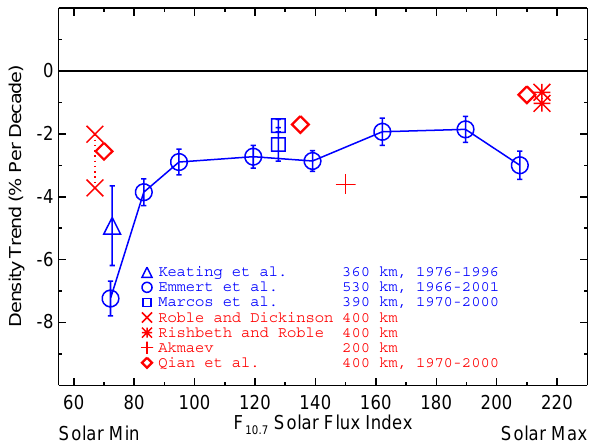
Fig. 2. Summary of density trends (with known natural variability removed) derived from the analysis of orbital tracking data, along with corresponding trends inferred from theoretical simulations of increased greenhouse concentrations. Keating et al. (2000) ana- lyzed the orbits of five objects during three solar minimum years (1976, 1986, and 1996). Emmert et al. (2004) analyzed 27 ob- jects, covering the period from 1966 to 2001, to derive long-term trends as a function of solar EUV irradiance. Marcos et al. (2005) analyzed 1970–2000 orbital data of 5 objects to obtain an overall trend covering all solar EUV conditions; the two trend estimates shown in the figure were obtained using different methods for re- moving the natural variability. Results are plotted against the aver- age solar EUV corresponding to each study and the average height is given in the legend. The theoretical simulations of Roble and Dickinson (1989) and Rishbeth and Roble (1992) were performed for 2 × CO 2 conditions, and that of Akmaev et al. (2006) was for 1.15 × CO 2 conditions; the inferred trend values shown here were obtained by interpolating the theoretical results to the actual per- decade increase in CO 2 that occurred over the past several decades. The values shown for Roble and Dickinson and Rishbeth and Roble were inferred using linear interpolation (top symbols) and geomet- ric interpolation (bottom symbols). The difference is negligible in the case of Akmaev’s result, and only the linearly interpolated value is shown. Qian et al. (2006) inferred linear trends from a continuous 30-year simulation (1970–2000), so no adjustment is necessary; the values shown are an average of their 350km and 450km